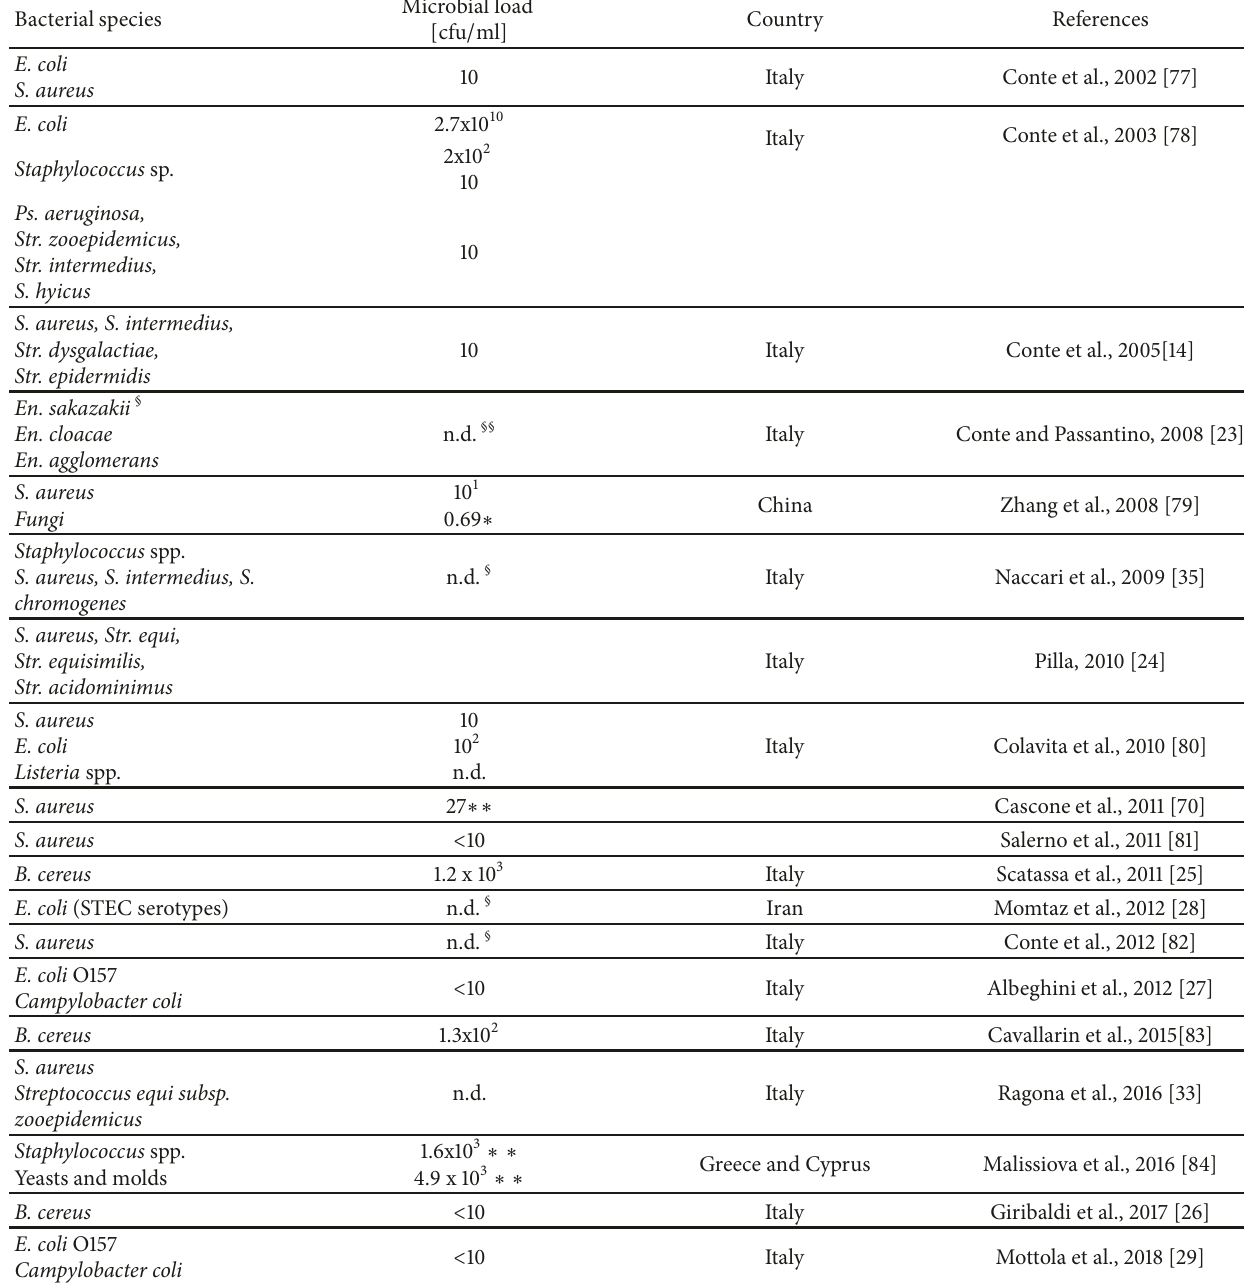
Table 1: Microorganisms isolated from donkey